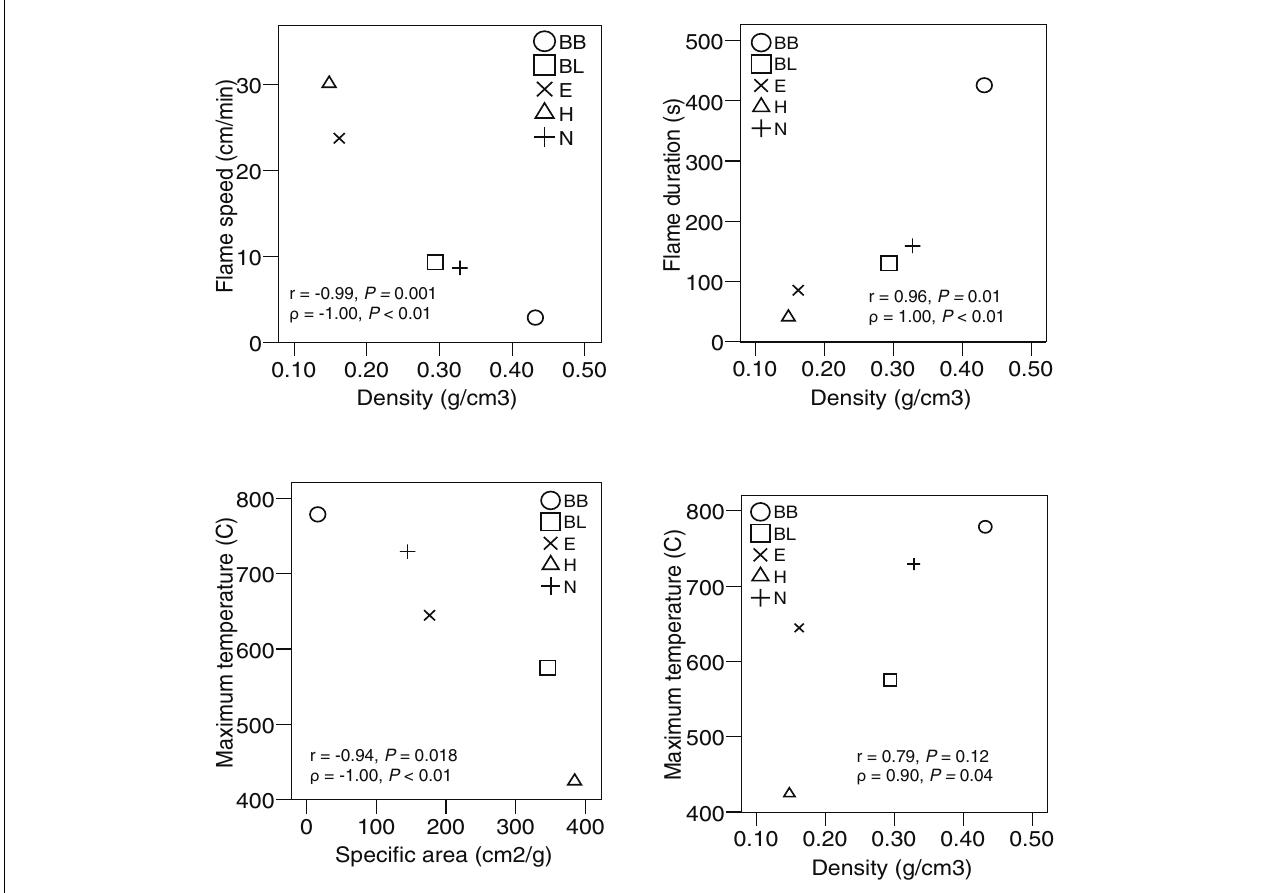
FIGURE 2 | Scatterplots of plant traits versus flammability variables. Symbols denote the five investigated fuel types (see Table 1 for codes). Only the significant relationships are